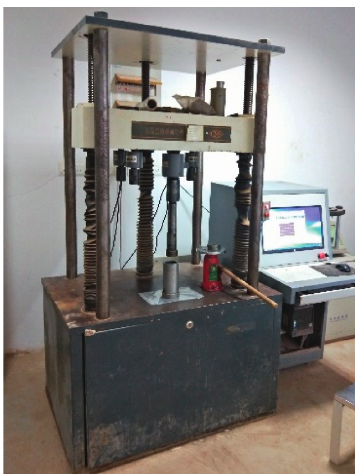
Figure 2: The picture of the specimen machine.